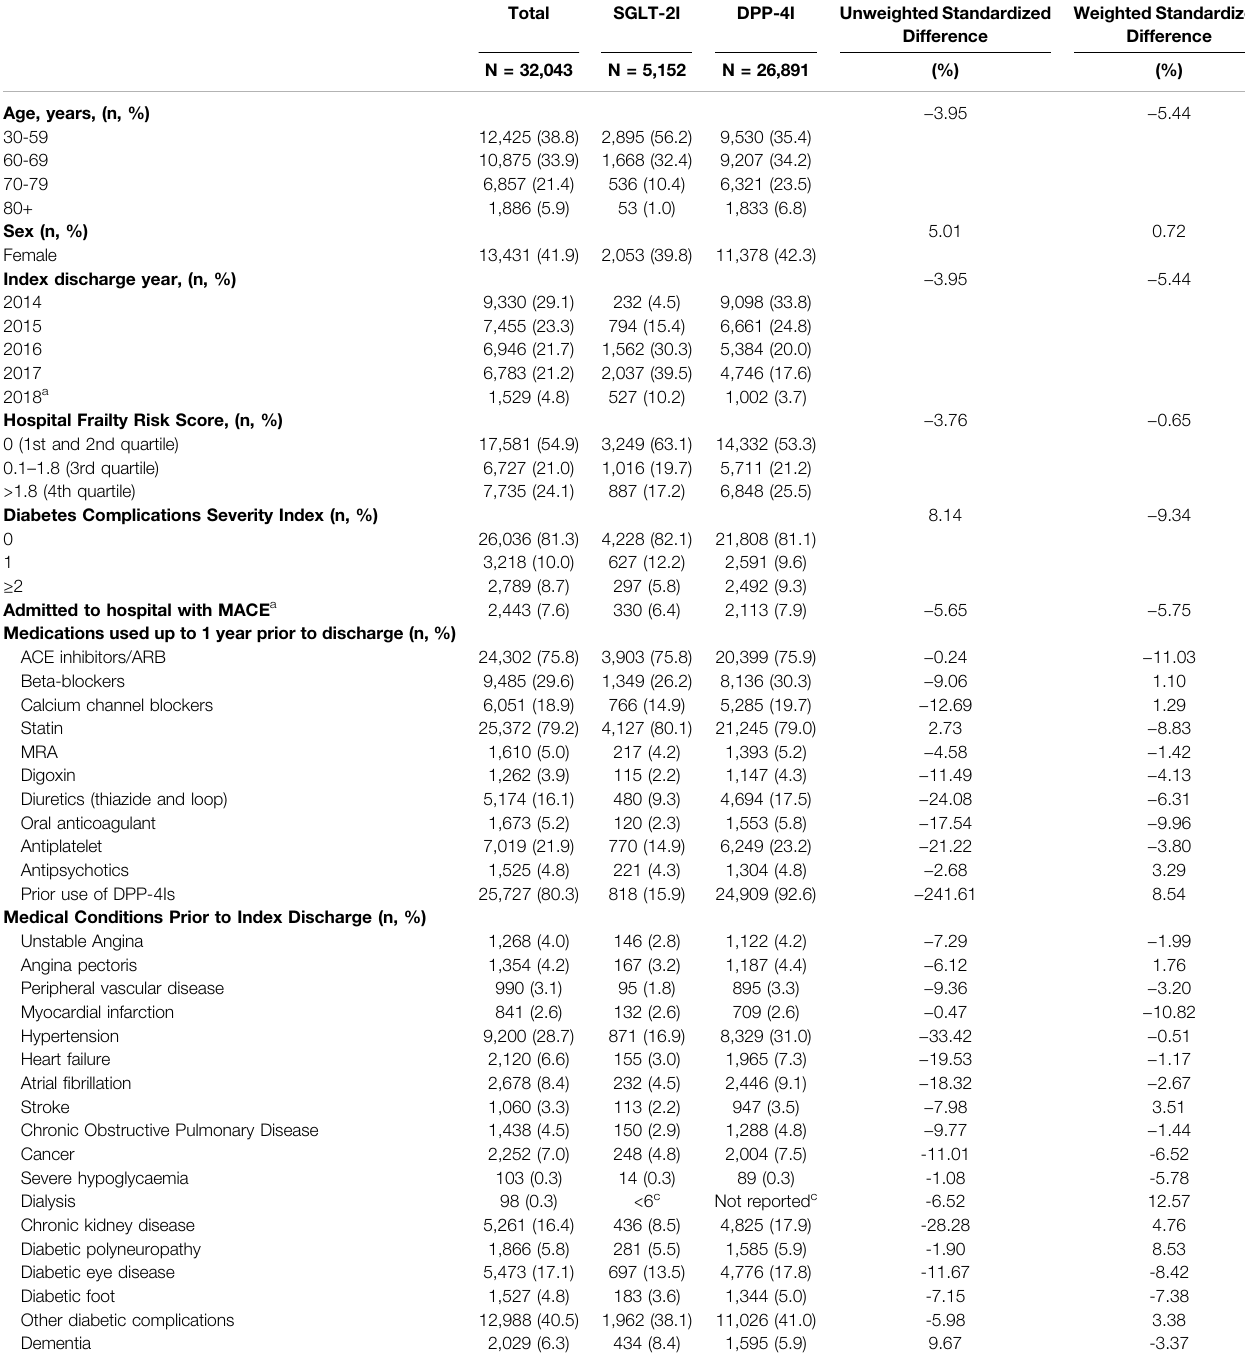
TABLE 1 | Baseline characteristics of patients hospitalised with type 2 diabetes with a history of metformin or sulfonylurea dispensings in the year prior to index discharge.